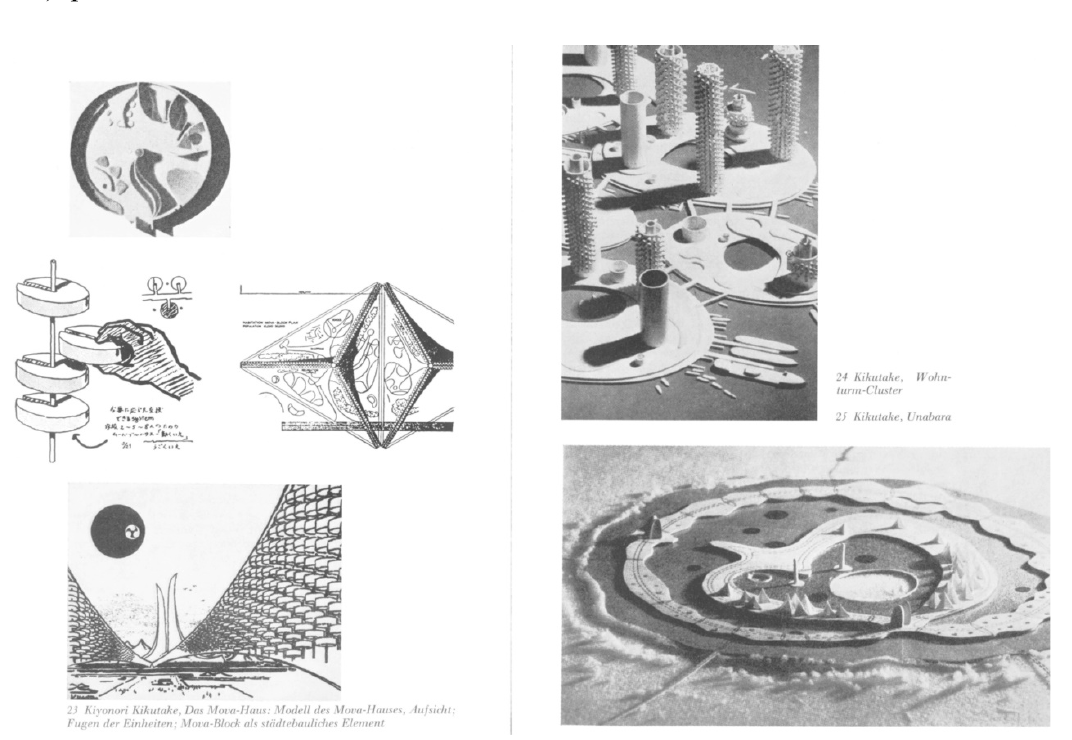
Figure 3. Kiyonori Kikutake’s ocean and marina projects, reproduced from Schumpp (1972), p.